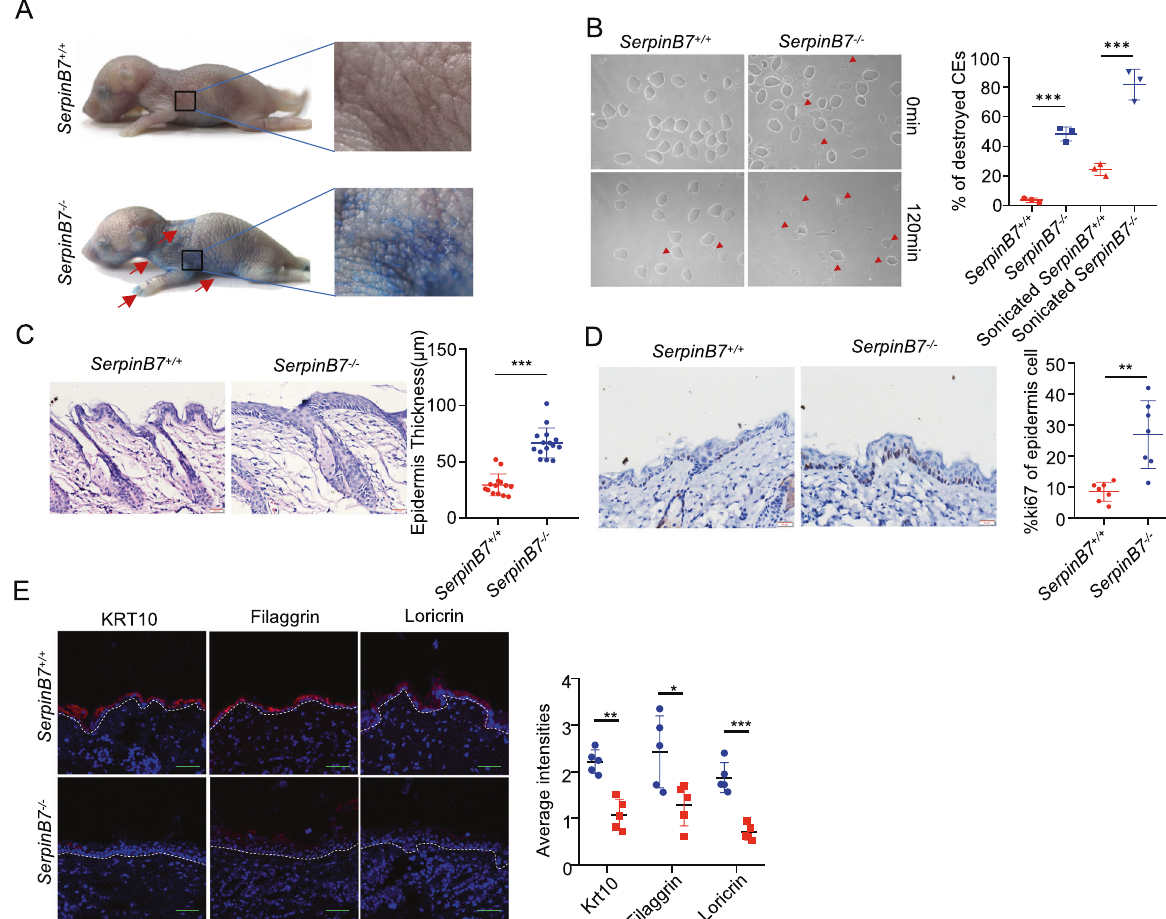
Fig. 2 SerpinB7 de fi ciency results in postnatal epidermal barrier defects and worsens psoriasis symptoms. A Toluidine blue dye- penetration assay was performed with newborn SerpinB7 + / + and Serpinb7 -/- mice indicating outside-in barrier defects. B SerpinB7 + / + and Serpinb7 -/- mice CEs were isolated and treated with ultrasound for 120 min. CE destruction is indicated by the triangle. C Representative H&E staining section (20×) from the skin tissues of SerpinB7 + / + and Serpinb7 -/- mice. Right: statistical analysis of skin epidermal thickness (mean ± SEM). D Representative immunohistochemical staining (20×) of Ki67 in the dorsal skin of SerpinB7 + / + and Serpinb7 -/- mice. Right: quanti fi cation of Ki67-positive cells in the epidermis. E Representative Immuno fl uorescent staining of Krt10, Filaggrin, and Loricrin in the dorsal skin of SerpinB7 + / + and Serpinb7 -/-